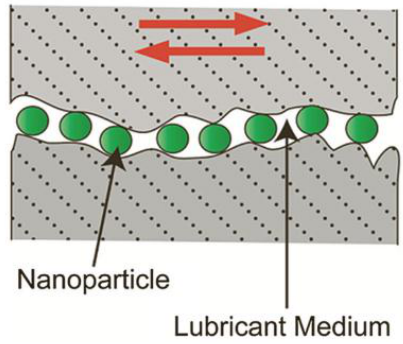
Figure 2. Illustration of a ball bearing mechanism. Reproduced with permission from reference Gulzar et al. [44], Copyright 2016, Springer.